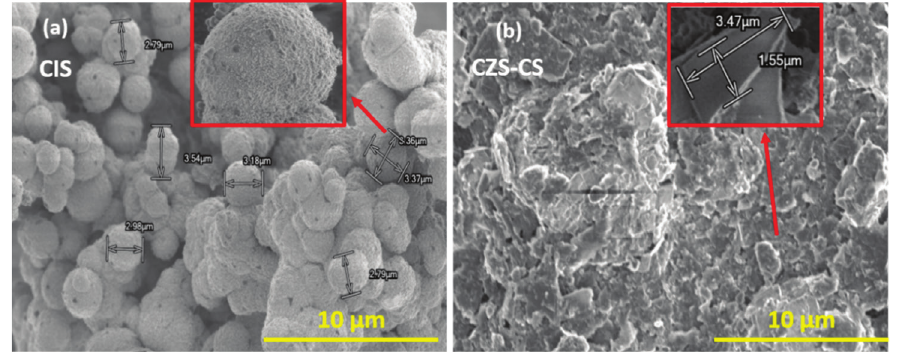
S and (b) Cd Zn S -ZnS composite thin films deposited on FTO substrate and insets are the 2 4 7.23 2.77 10